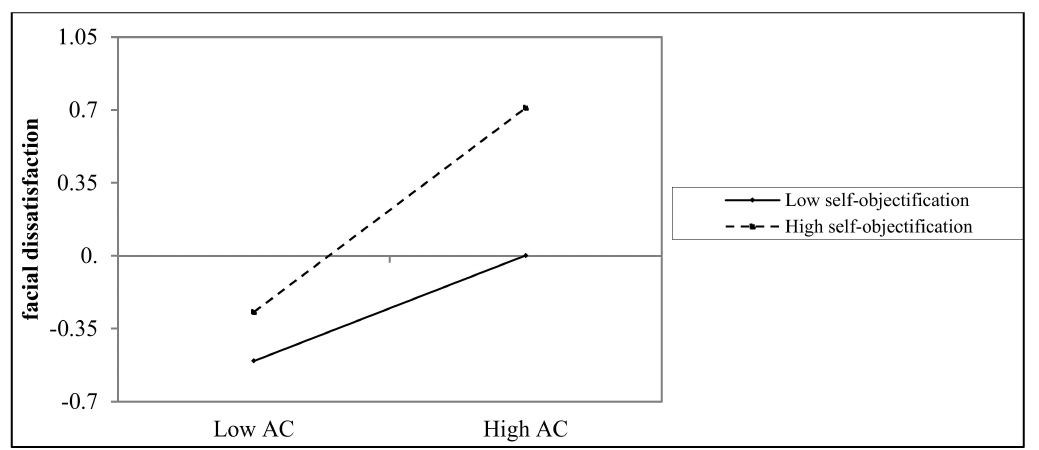
Figure 2. The interaction between appearance comparisons and self-objectification on facial